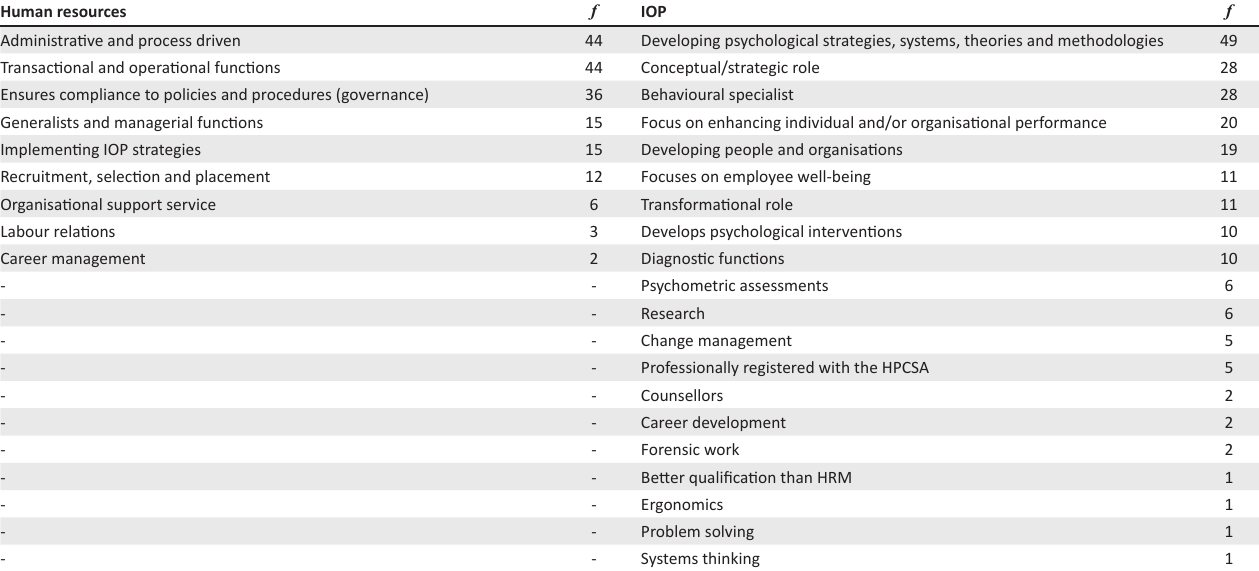
TABLE 5: Differences between HRM and